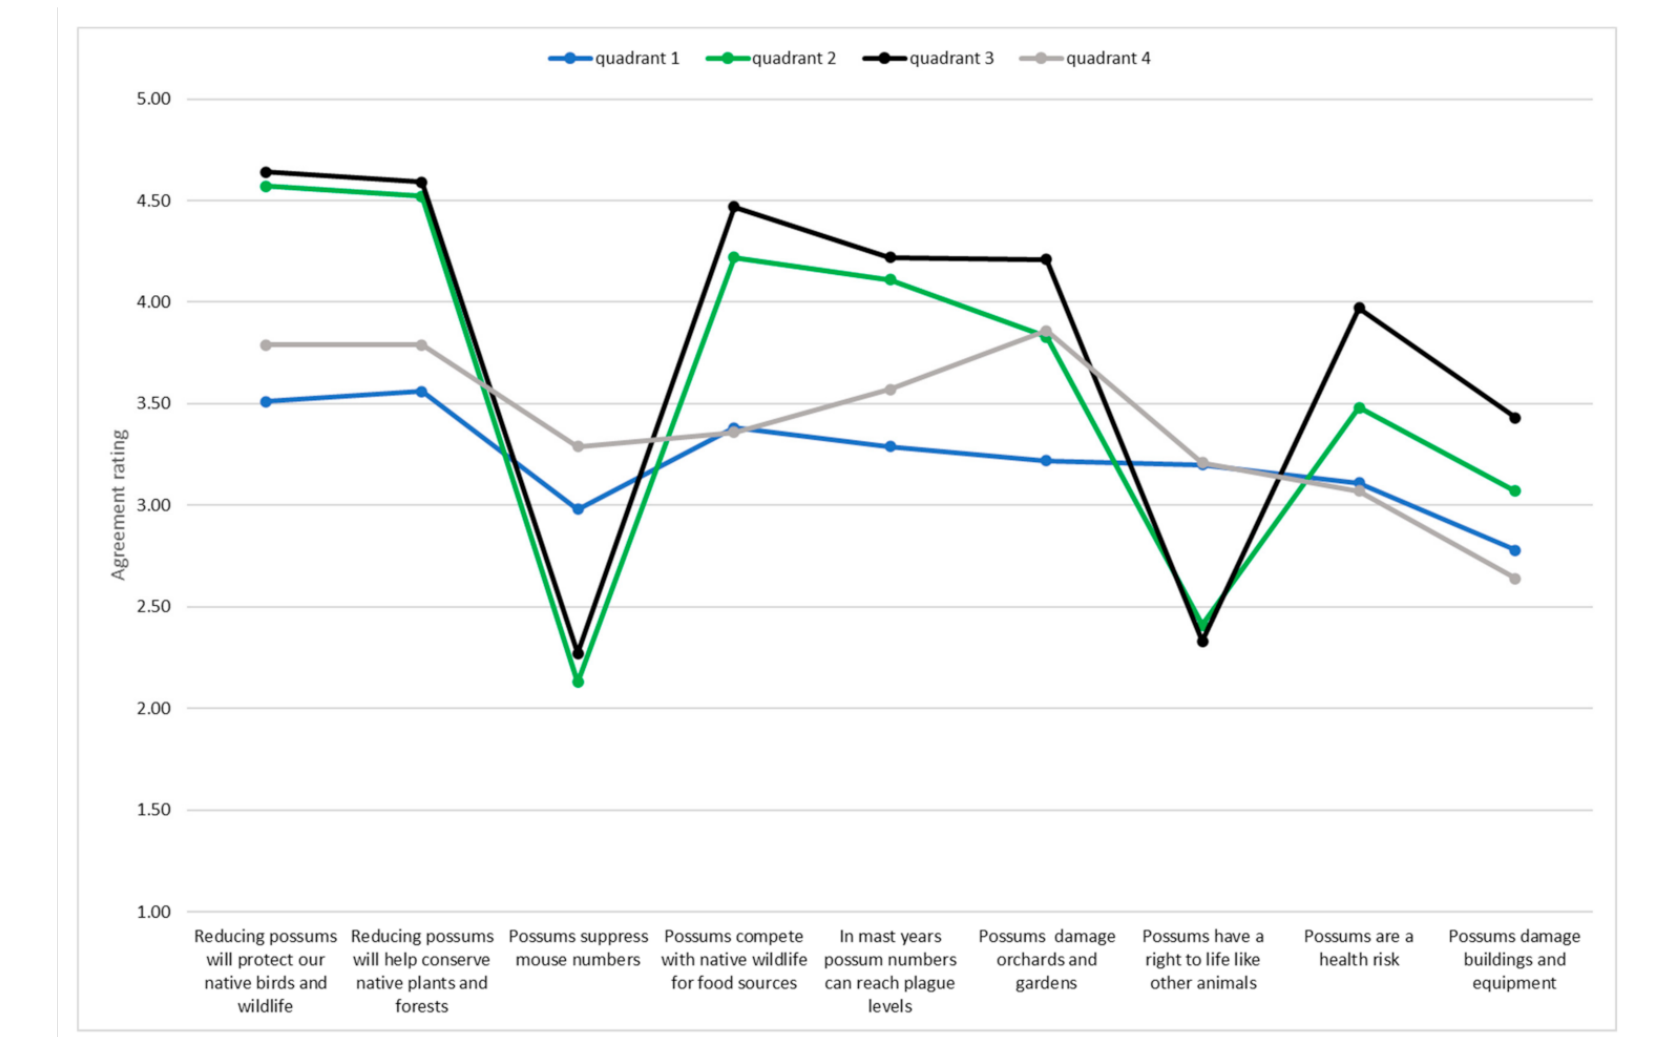
Figure 5. Respondents’ beliefs about the advantages and disadvantages of reducing possum